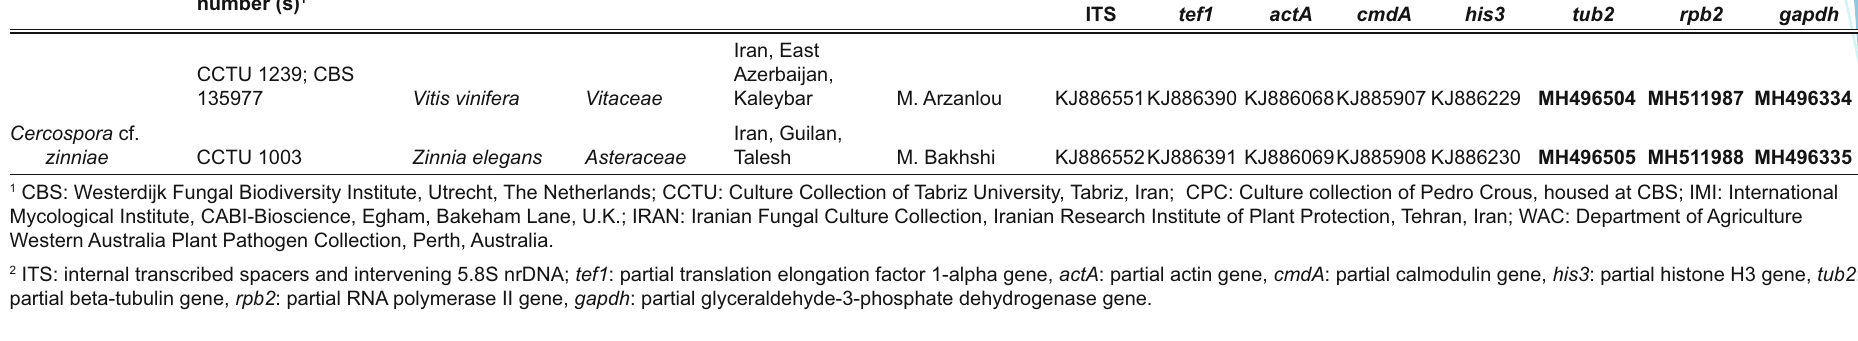
Table 2. =(cid:10)(cid:11)(cid:6)(cid:13)(cid:10)(cid:2)(cid:19)(cid:4)(cid:6)(cid:12)(cid:11)(cid:17)(cid:9)(cid:8)(cid:11)(cid:4)(cid:17)(cid:7)(cid:2)(cid:5)(cid:7)(cid:13)(cid:21)(cid:2)(cid:21)(cid:5)(cid:10)(cid:11)(cid:17)(cid:25)(cid:2)(cid:8)(cid:14)(cid:11)(cid:7)(cid:2)(cid:7)(cid:8)(cid:5)(cid:21)(cid:22)(cid:2)(cid:26)(cid:4)(cid:10)(cid:2)(cid:9)(cid:6)(cid:18)(cid:23)(cid:11)(cid:20)(cid:19)(cid:9)(cid:8)(cid:11)(cid:4)(cid:17)(cid:2)(cid:9)(cid:17)(cid:21)(cid:2)(cid:7)(cid:13)T(cid:5)(cid:13)(cid:17)(cid:19)(cid:11)(cid:17)(cid:25)(cid:28) Locus